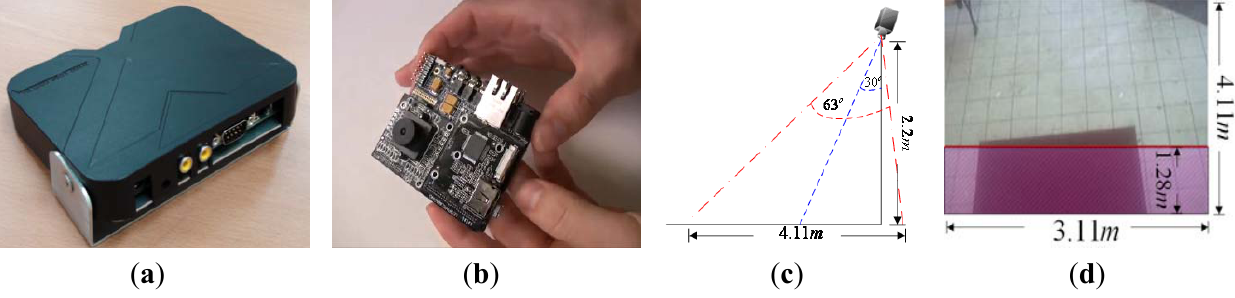
Figure 5. Prototype of the proposed system and the installation parameters illustration. ( a ) and ( b ) are the system prototype appearance and designed hardware platform, respectively. ( c ) and ( d ) illustrate the system installation example and the area for infrared signal